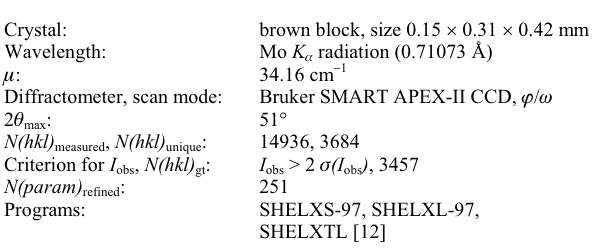
Table 1. Data collection and handling.